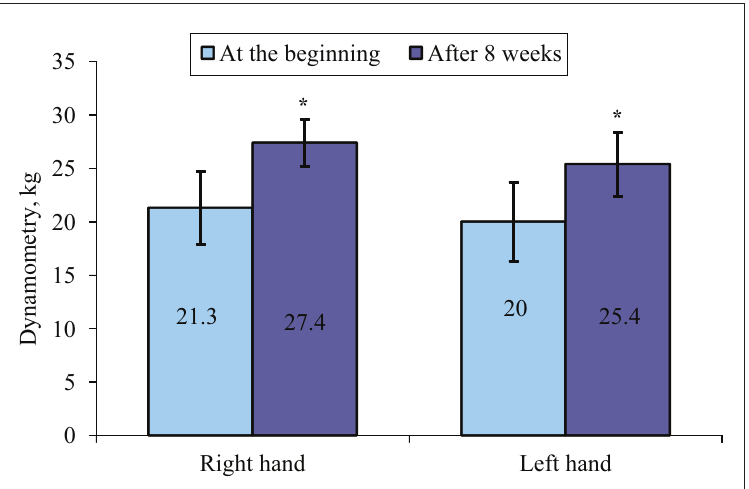
Figure 1. Depression and anxiety symptoms in the experimental group at the beginning and after an 8-week strength training program